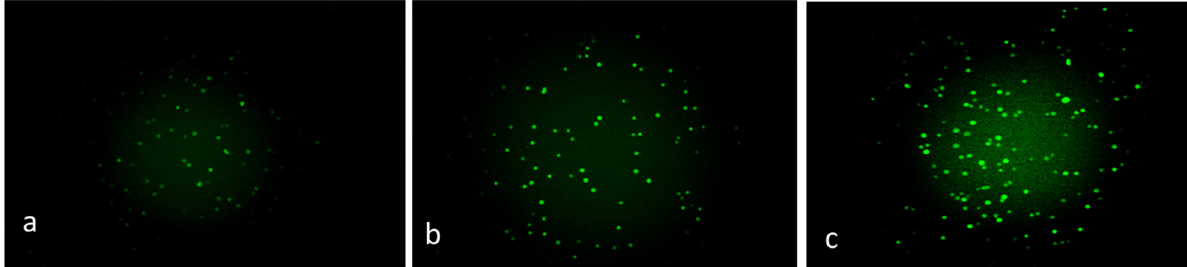
Figure 11: Fluorescence microscopic images of intracellular ROS generation induced by ZnO – TiO 2 – chitosan – escin bio - nanocomposites in MOLT4 cells stained with DCFH - DA. ( a ) Untreated control cells, ( b ) cells treated with 30 μ g · mL − 1 , and ( c ) 40 μ g · mL − 1 of ZnO – TiO 2 – chitosan – escin bio - nanocomposites. These are representative images of the experiment performed in triplicates with magni - fi cation at 20 ×